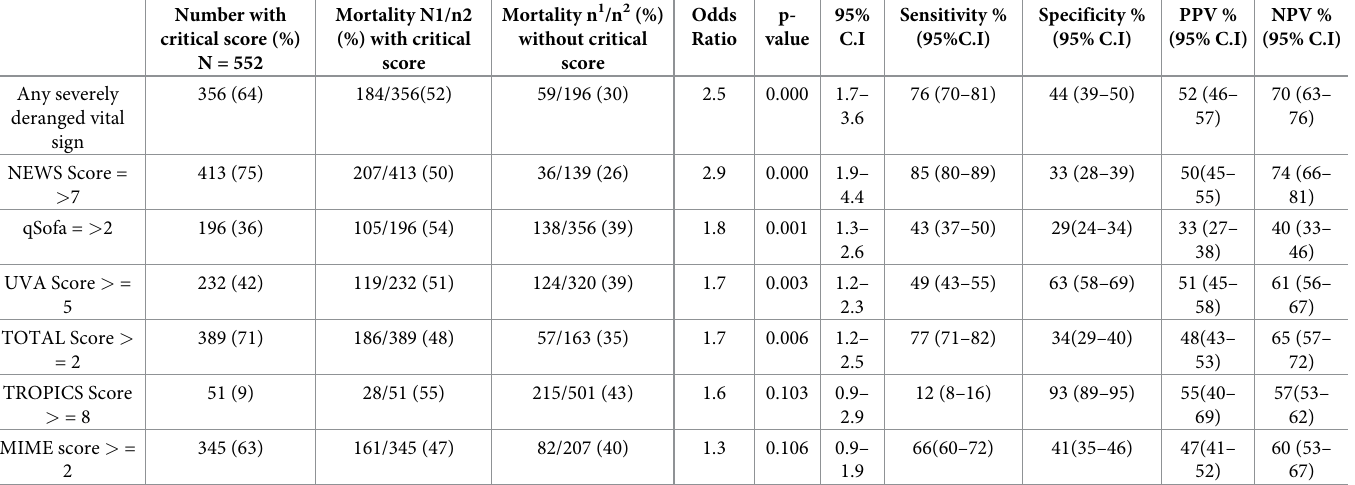
Table 5. Predictive values of severity score models for surgical patients over 16